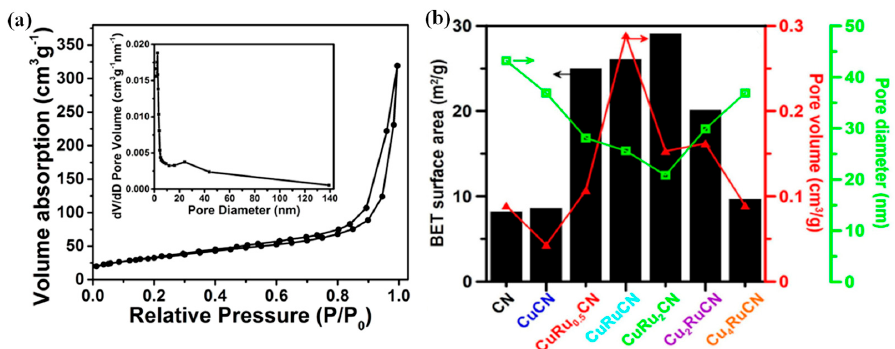
Figure 14. ( a ) BET plot of 4 wt% Au − CDots − C 3 N 4 ; ( b ) BET surface area (black), pore diameter (green), and pore volume (red) of the Cu x Ru y CN [124] . Reprinted with permission from Ref. [124]. Copyright 2021 Copyright Elsevier (Amsterdam, The Netherlands). Table 5. Advantages and disadvantages of porous polymer materials for CO 2 capture and electrocat- alytic